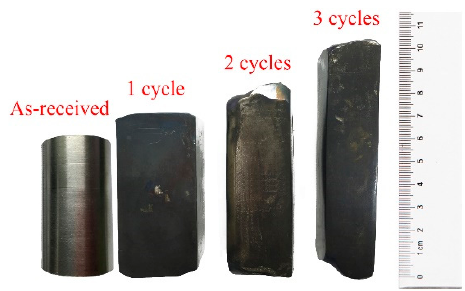
Figure 3. Macroscopic morphology of as-received and MDF (multi-directional forging) CP Ti.